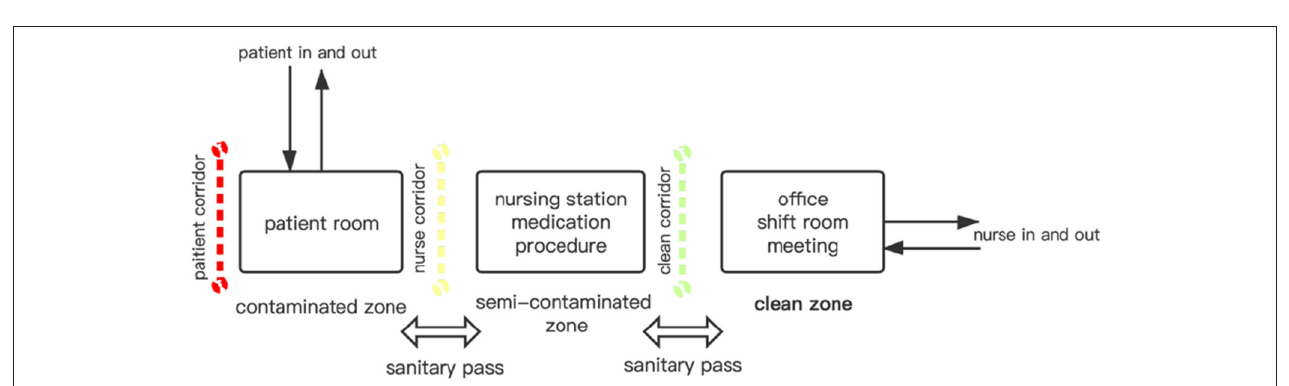
but connected to the patients. Their nurse station was open to the semi-contaminated area, where the exposure to the infection was